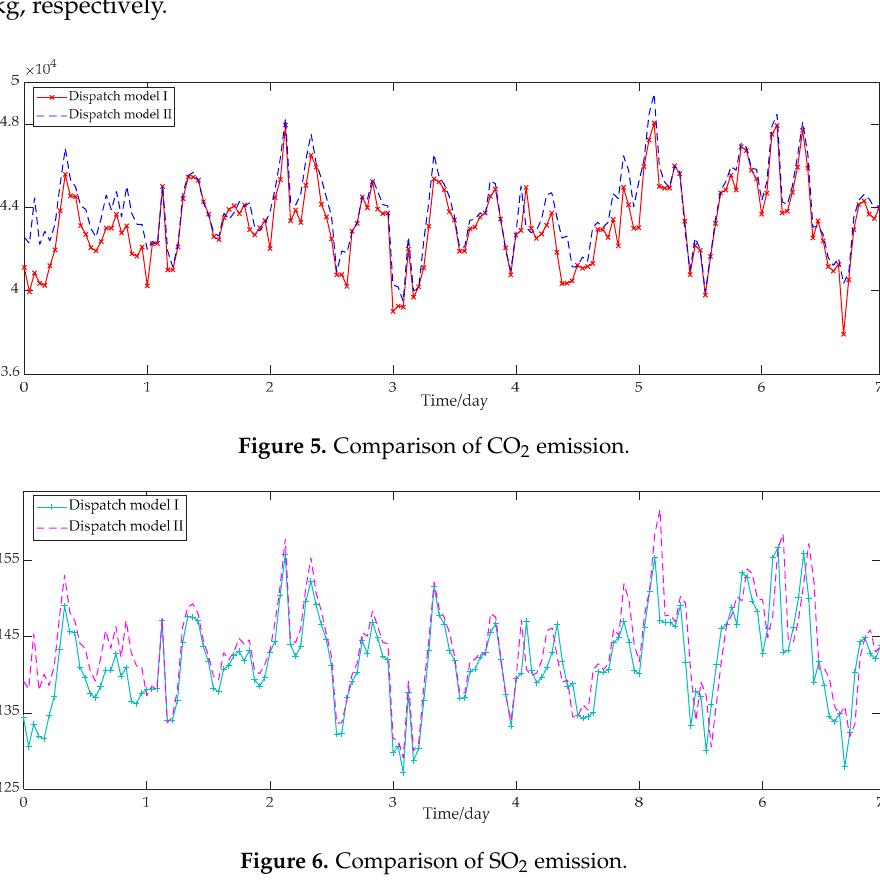
Figure 7. Comparison of NO x emission. Figure 8. Comparison of wind power accommodation.